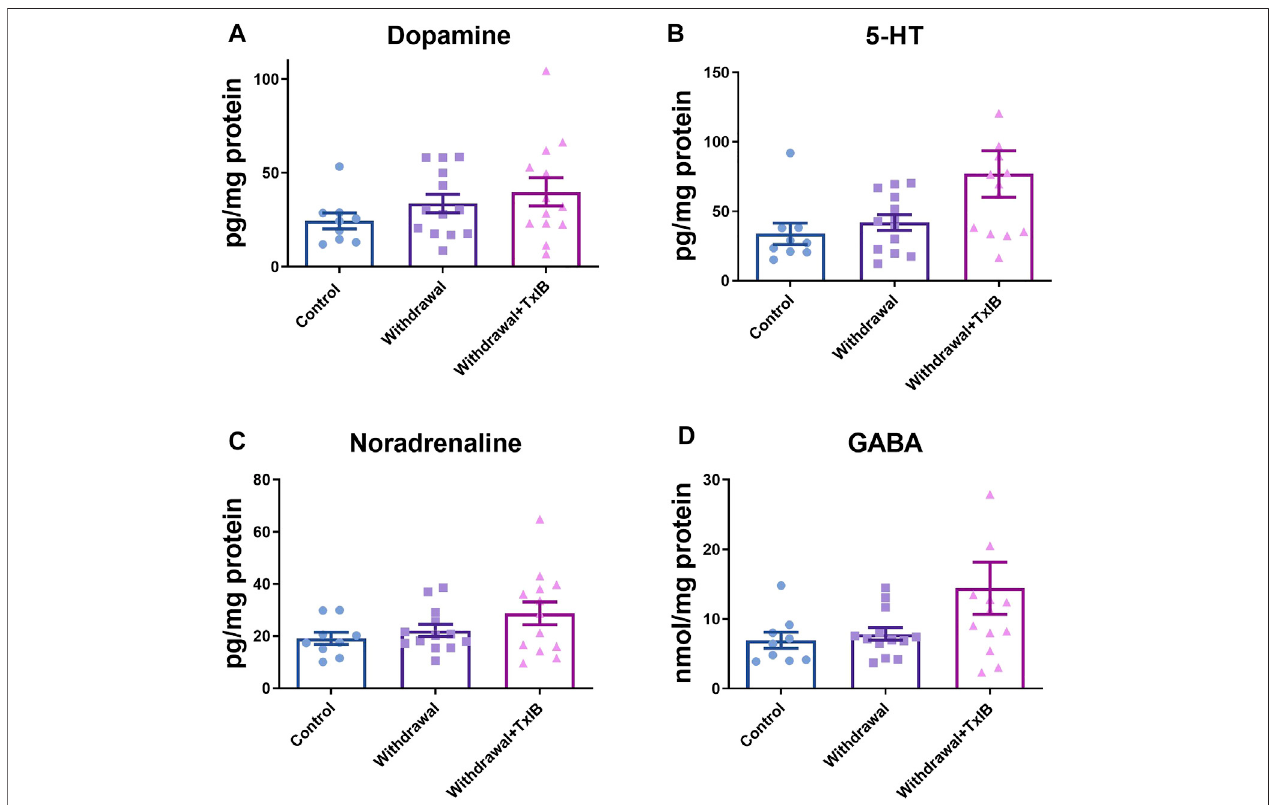
FIGURE 2 | Monoamine neurotransmitter content in the whole zebra fi sh brain; (A) Dopamine content; (B) 5-HT content; (C) Noradrenaline content; (D) GABA content. TxIB concentration of 1 mg/kg was used. Data are mean ± SEM of 9 – 13 zebra fi sh per group. One-way ANOVA followed by Tukey ’ s multiple comparisons test was